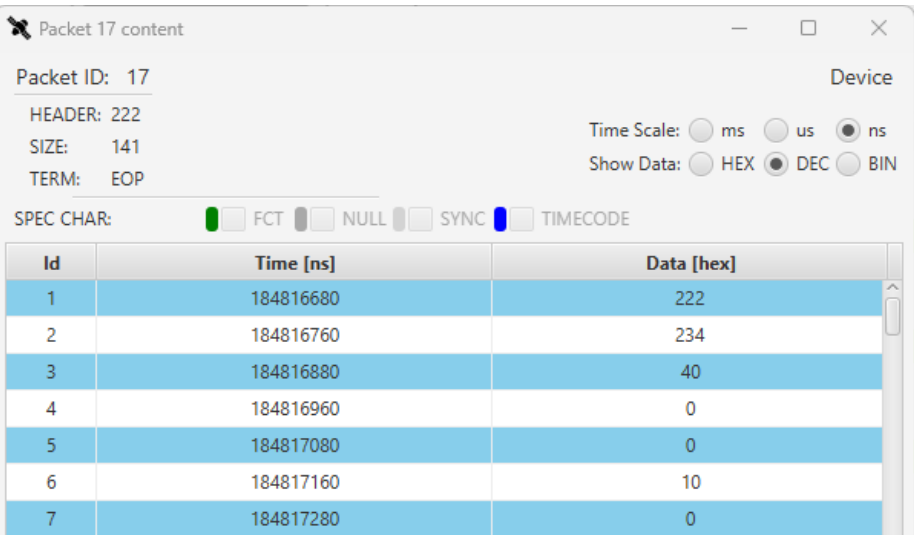
Figure 9. SpaceART Sniffer GUI visualization of the content of the 17th TM1 packet transmitted by the device in Test